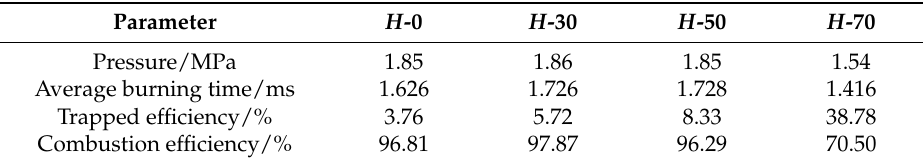
Table 1. Calculation result parameter distribution.